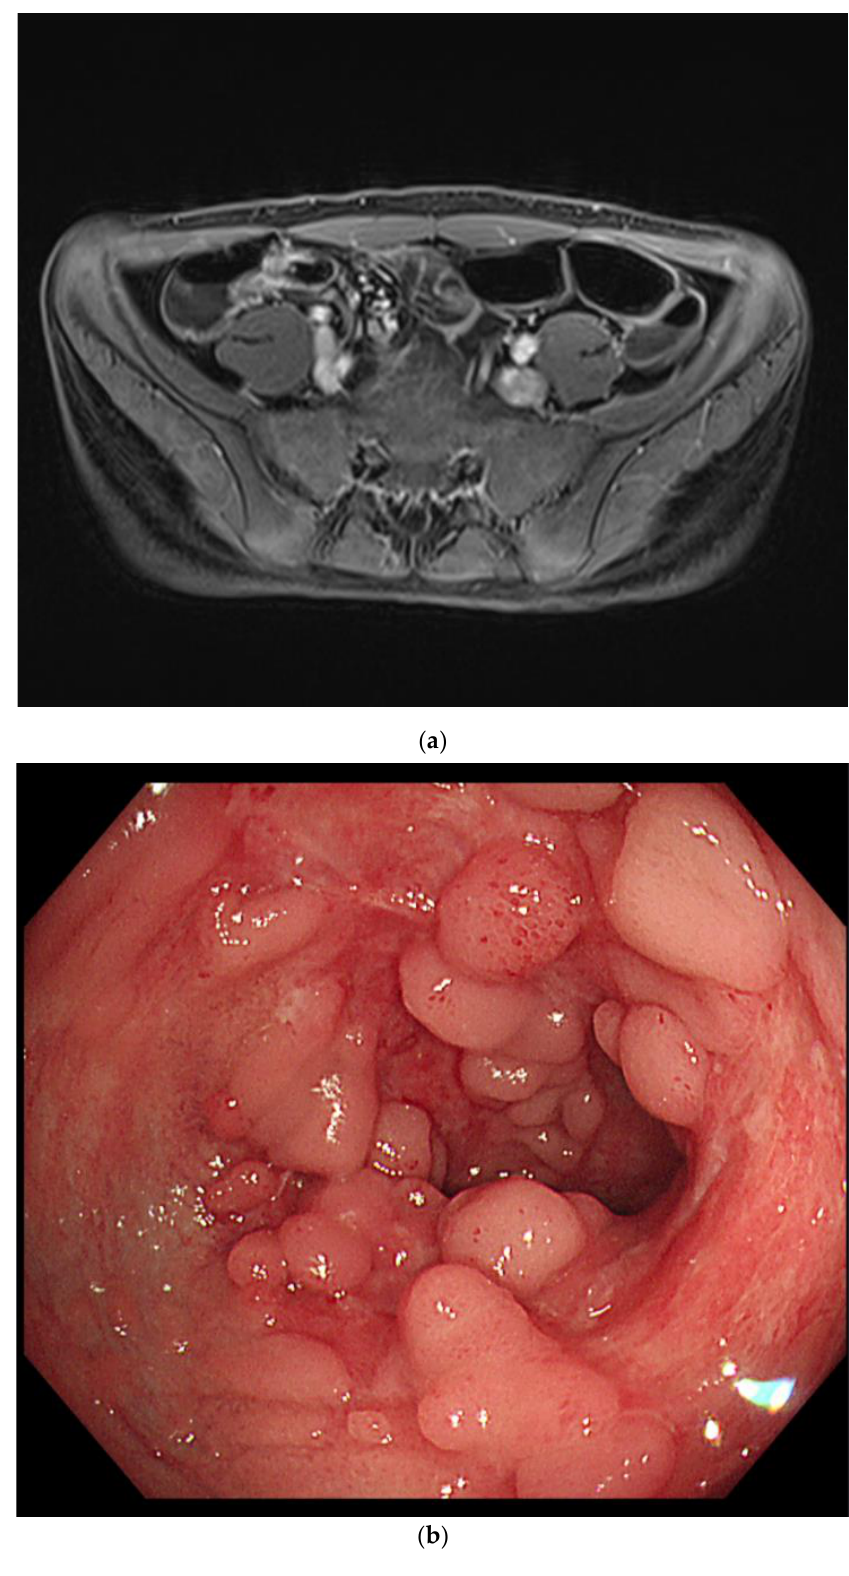
Figure 4. Magnetic resonance enterography demonstrated wall thickening of the distal ileum, including the ileocecal valve ( a ). Colonoscopy revealed healing scars and pseudopolyps of the terminal ileum ( b ).